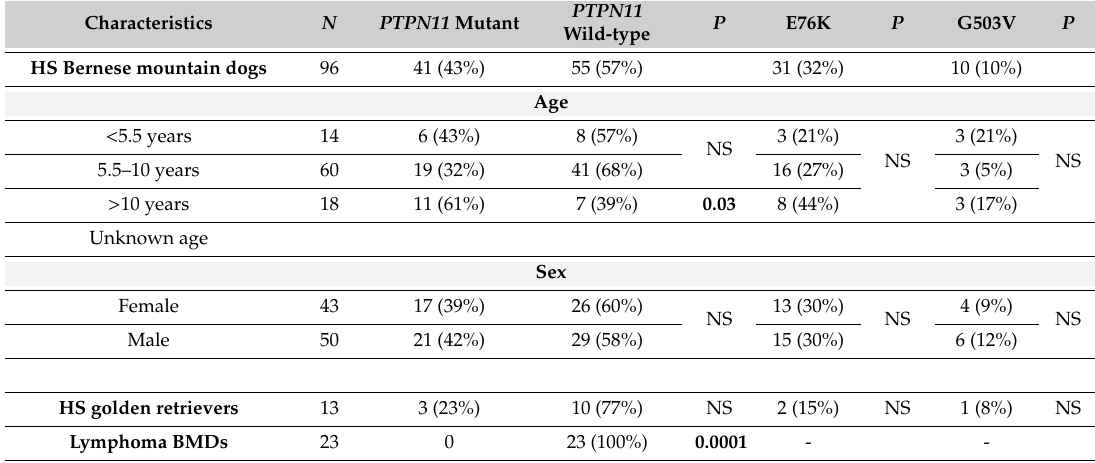
Table 1. Frequency of tumor PTPN11 mutation status based on breed, age, sex, and disease type. Characteristics